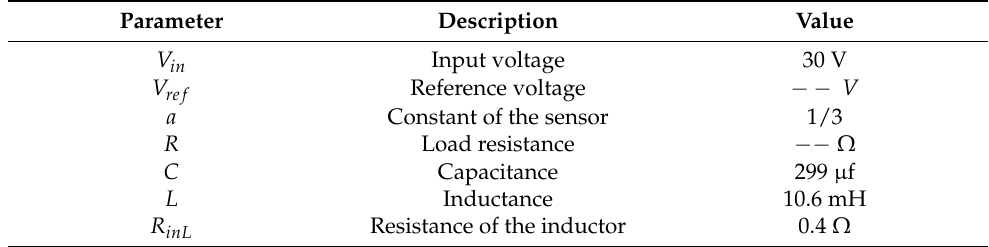
Table 2. Parameters of the Buck converter with the zero-hysteresis control for the experimental test.